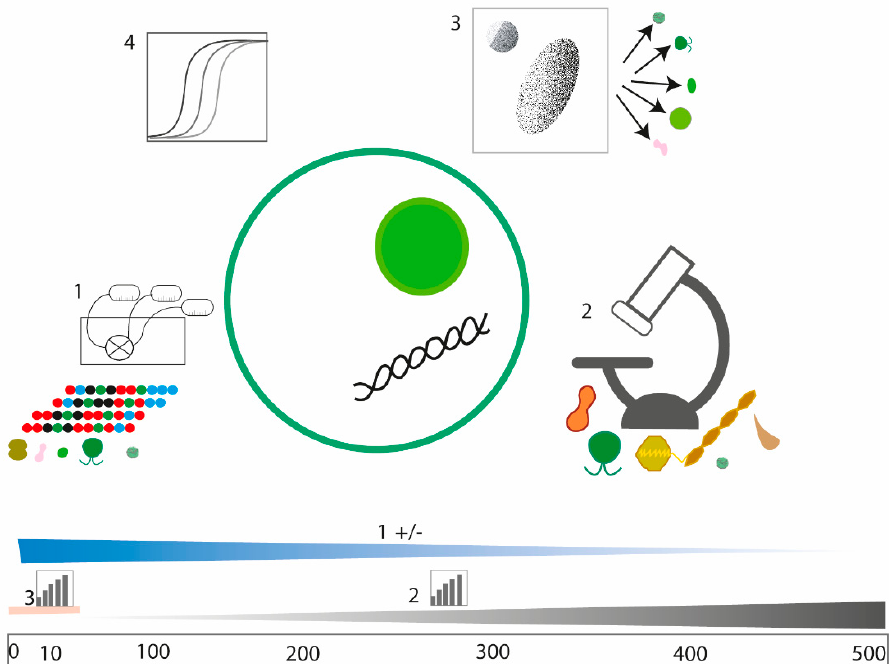
Figure 10. Schematic synthesis of the advantages of HTS from WaMS sampling machine (1), microscopy (2) and flow cytometry (FC) (3) and qRT-PCR (4) used to assess phytoplankton diversity and abundance in the Western channel and commonly used in other monitoring stations. The bottom bar represents the sizes of phytoplankton in µm. Barchart symbols indicate quantitative methods, and +/ − indicates the presence or absence of diversity metrics produced by HTS but capable of deep-level detection of rare taxa. Used alongside qRT-PCR, it can be quantitative for a limited number of taxa. Gradients indicate the size range of taxa assemblages for each method, microscopic methods being biased towards larger-sized phytoplankton and WaMS HTS biased towards smaller-sized phytoplankton. FC has limited taxa resolution at a smaller size range but is quantitative and can be augmented by other methods.